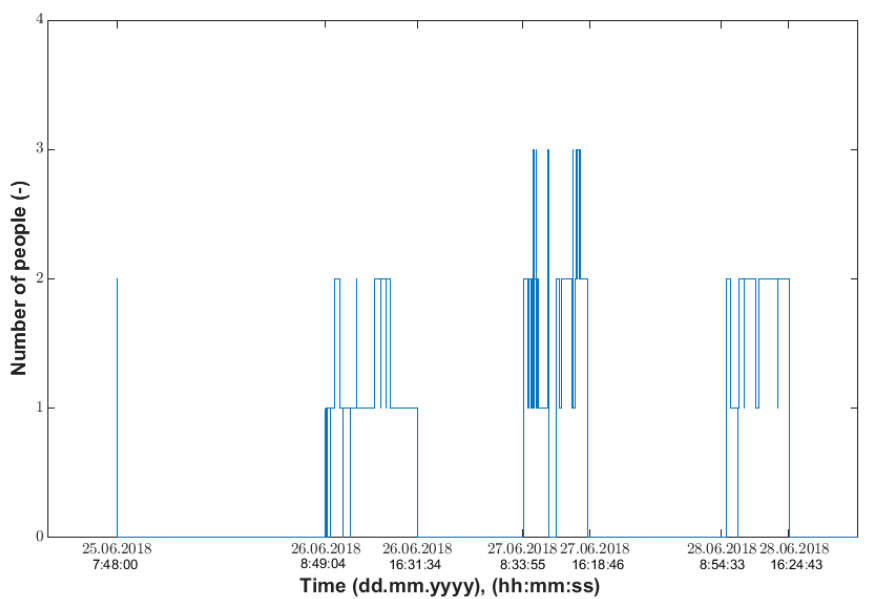
11 of 29 Figure 11. The waveform of signals from FBG A and FBG B sensors during the 24-h measurement of recognition of the number occupants in room R104 in the period from 25 June 2018 (7:48:00), to 28 June 2018 (23:59:00). To detect the number of occupants on the first floor, an algorithm was implemented in the